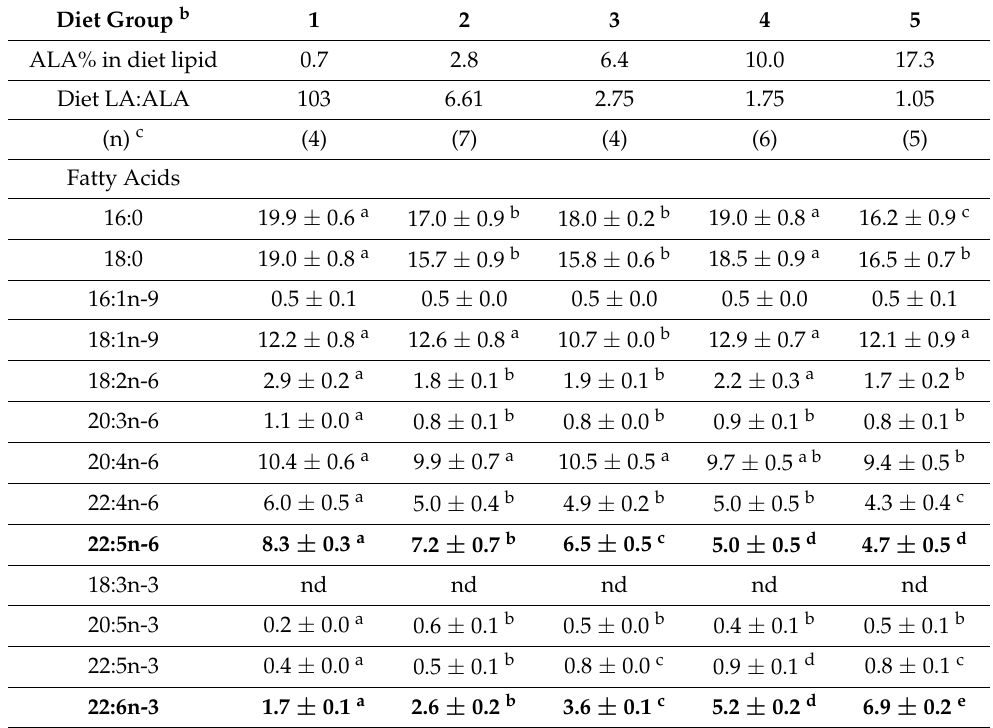
Table A2. Effect of increasing dietary ALA on brain fatty acid proportions (g/100 g phospholipid fatty acids) a .